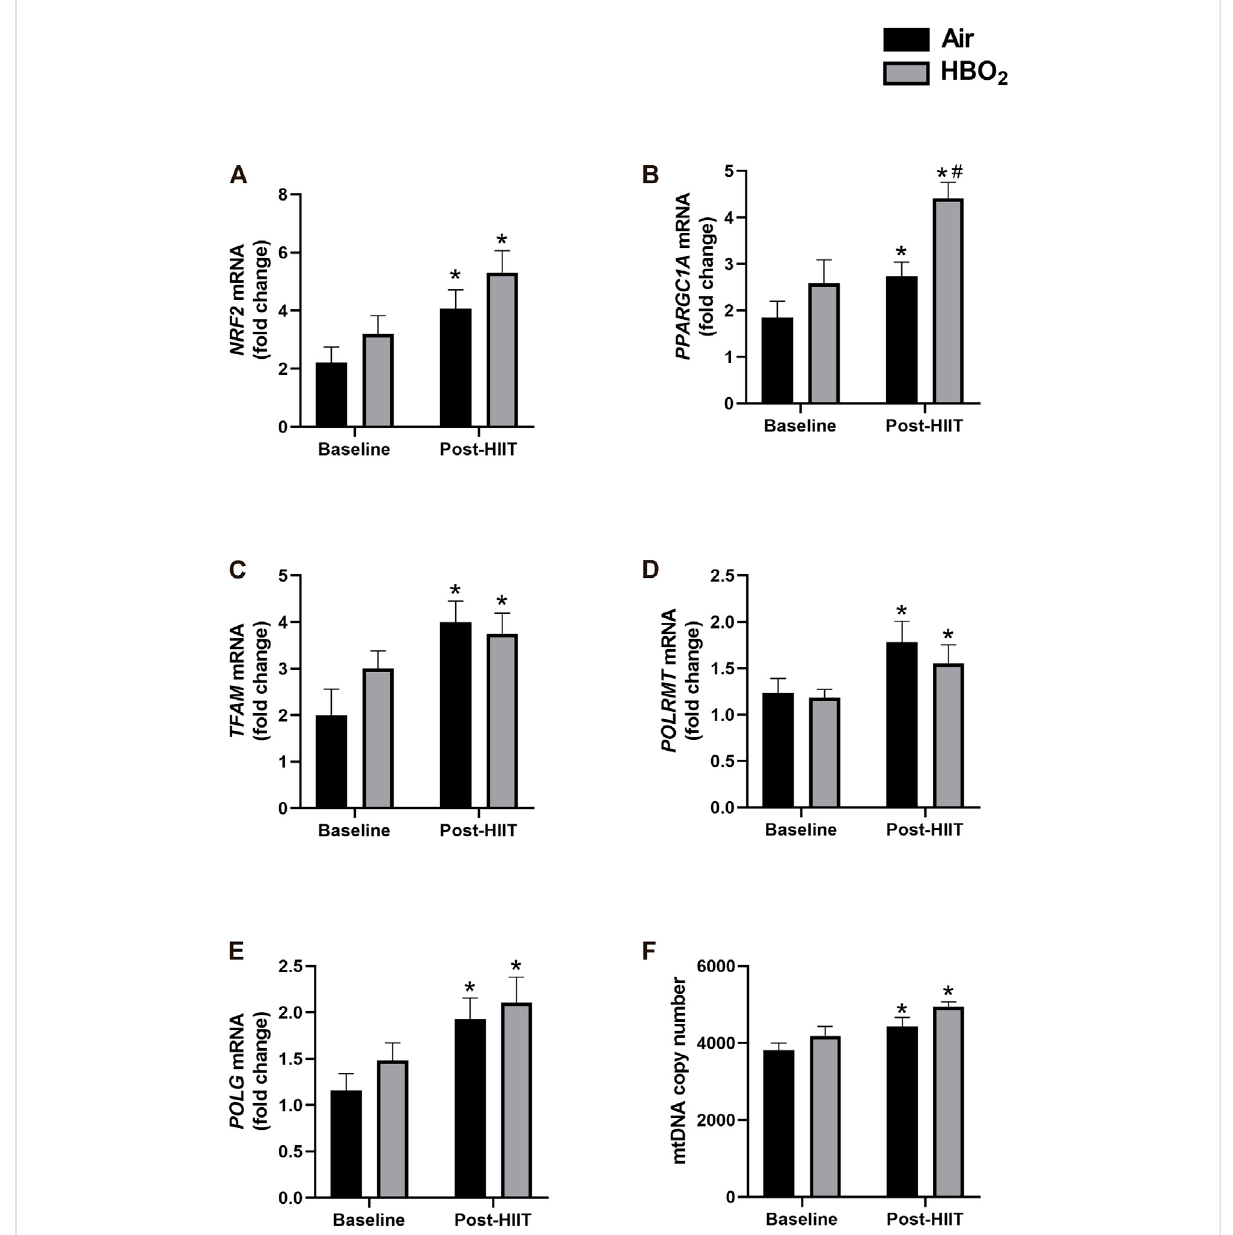
FIGURE 4 Mitochondrial gene expression. mRNA levels of the following genes weremeasured byquantitativePCR: (A) NRF2 , nuclear respiratory factor 2; (B) PPARGC1A , peroxisome proliferator-activated receptor gamma coactivator 1-alpha; (C) TFAM , mitochondrial transcription factor a; (D) POLG , DNA polymerase subunit gamma-1; and (E) POLMRT , mitochondrial DNA-directed RNA polymerase. Reference mRNA was 18S and shown as fold- change.MitochondrialDNAcopynumberwasmeasuredin (F) byPCRwith18SrDNAasreferenceandshownasfold-change.Statisticalanalysis was 2-way ANOVA with repeated measures and Fisher ’ s LSD post-hoc test. * p < 0.05 shows signi fi cant within group comparison (i.e. baseline vs. post-HITT) and # p < 0.05 shows signi fi cant between group comparisons (i.e. air, black bars vs. HBO 2 , grey